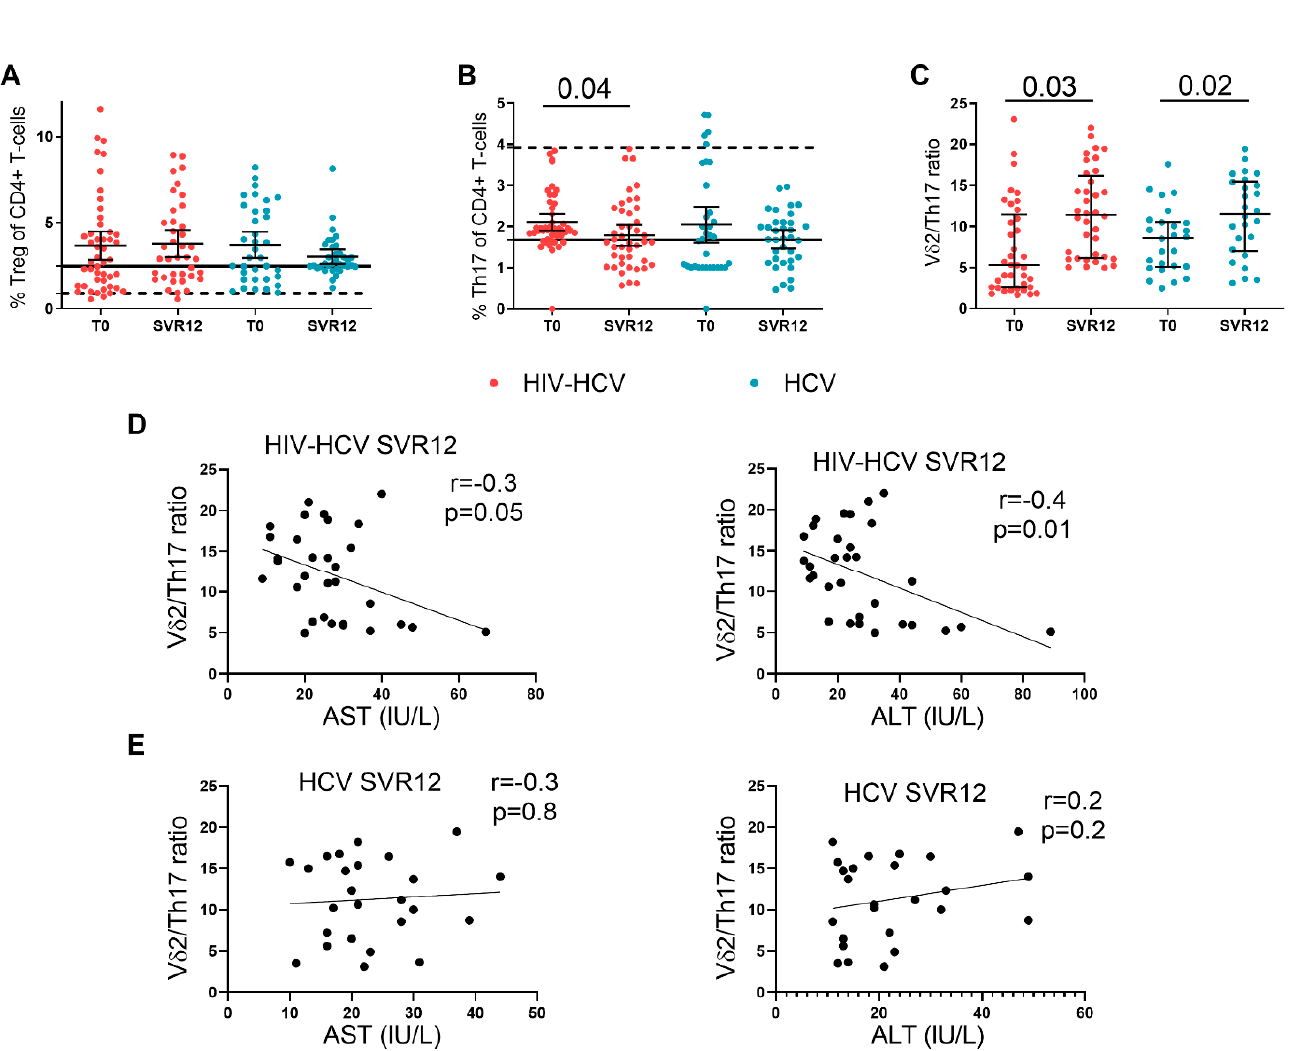
Figure 2. Treg, Th17, and V δ 2/Th17 ratio and correlation between V δ 2/Th17 ratio and liver function enzymes in the HIV-HCV co-infected and HCV mono-infected individuals that were undergoing DAA treatment. ( A ) Frequencies of Treg in the HIV-HCV co-infected and HCV mono-infected individuals prior and following DAA treatment. Wilcoxon matched-pairs test ( n = 38 and n = 35) and Mann–Whitney test. For this experiment, HIV mono-infected individuals ( n = 15; bold line) and healthy controls ( n = 10; dotted line) are also shown. The HCV mono-infected individuals showed significantly higher Treg cell frequencies than the healthy controls both before and after DAA treatment (T0: 2.3% [IQR: 1.7–5.7] vs. 0.82% [IQR: 0.62–1.95]; p -value = 0.0001; SVR 12: 3% [IQR: 1.87–5.22] vs. 0.82% [IQR: 0.62–1.95]; p = 0.0002) ( B ) The frequencies of Th17 in the HIV-HCV co-infected and HCV mono-infected individuals prior and following DAA treatment. Wilcoxon matched-pairs test ( n = 43 and n = 35) and Mann–Whitney test. For this experiment, the HIV mono- infected individuals ( n = 15; bold line) and healthy controls ( n = 10; dotted line) are also shown. HCV mono-infected individuals showed significantly lower Th17-cell frequencies than the healthy controls both before and after DAA treatment (T0: 1.75% [IQR: 1–3] vs. 3.92% [IQR: 3.38–5.62] p -value = 0.002; SVR 12: 1.71% [IQR: 1.17–2.1] vs. 3.92% [IQR: 3.38–5.62]; p < 0.0001) ( C ) The V δ 2/Th17 ratio in HIV-HCV co-infected and HCV mono-infected individuals prior and following DAA treatment. Wilcoxon matched-pairs test ( n = 31 and n = 26) and Mann–Whitney test. ( D ) Spearman’s correlation between V δ 2/Th17 ratio and aspartate aminotransferase (AST) and alanine aminotransferase (ALT) in 31 HIV-HCV co-infected individuals after DAA treatment. ( E ) Spearman’s correlation between V δ 2/Th17 ratio and aspartate aminotransferase (AST) and alanine aminotransferase (ALT) in 25 HCV mono-infected individuals after DAA